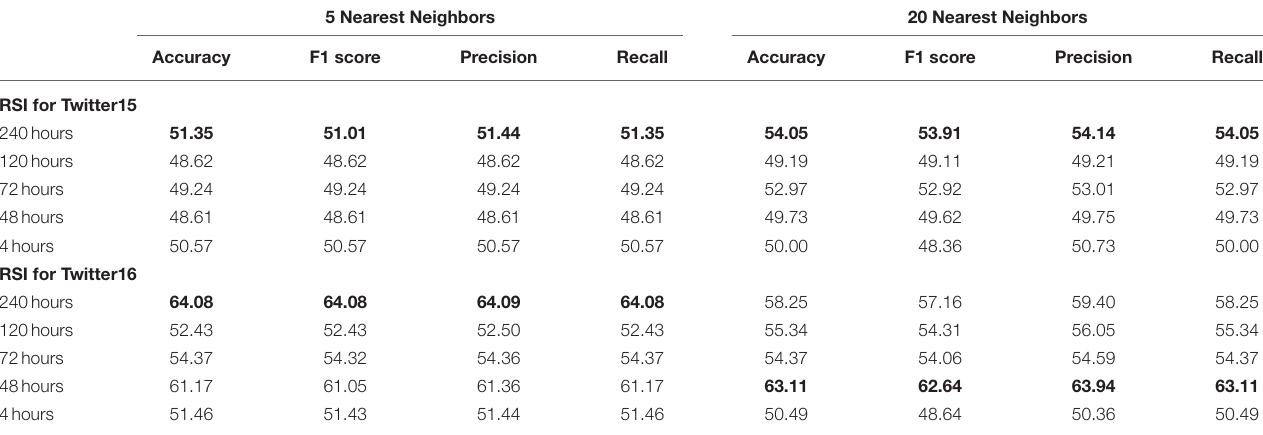
TABLE 5 | RSI classification results for Twitter15 and Twitter16